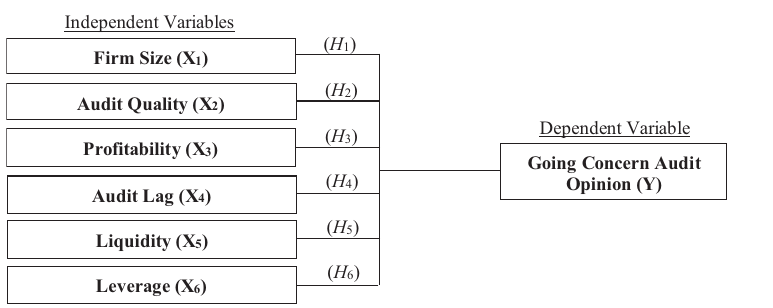
Figure 1. Conceptual